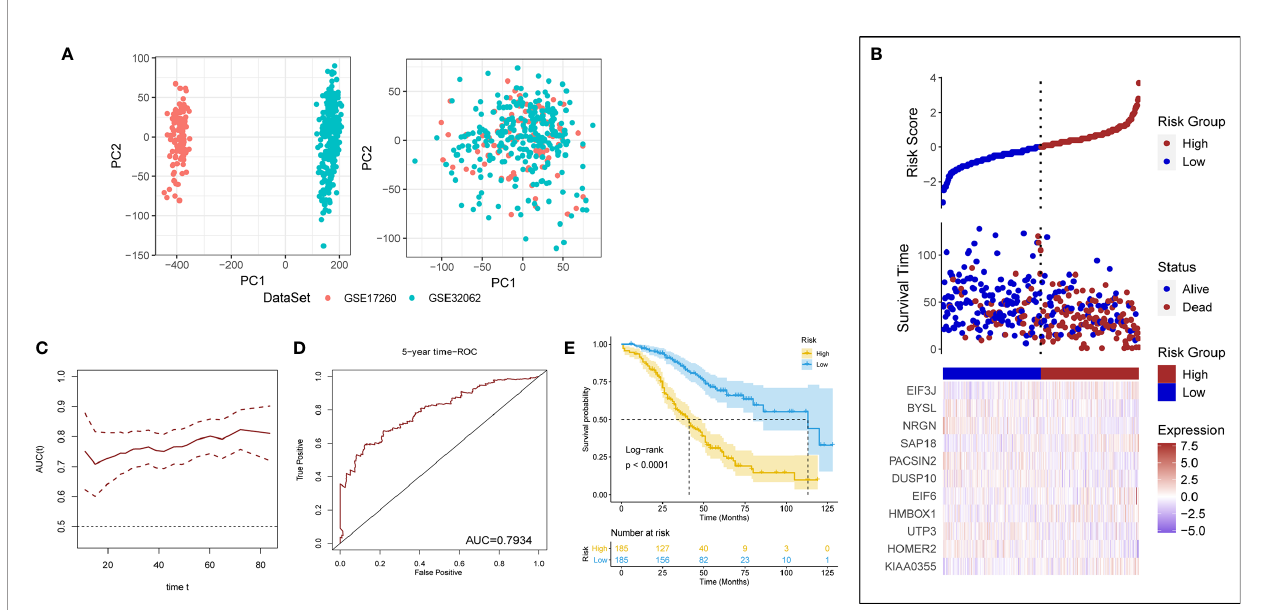
FIGURE 2 | The liquid-liquid phase separation-related gene signature in the discovery set. (A) PCA results before (left) and after (after) removing batches between GSE17260 and GSE32062. PC, principal component. (B) The 11 genes of interest constitute the liquid-liquid phase separation-related gene signature. (C) The time receiver operating characteristic curve (ROC) analysis in the discovery set. (D) The fi ve-year time ROC in the discovery set. (E) The patients with high risk index had signi fi cantly shorter overall survival than those with low risk